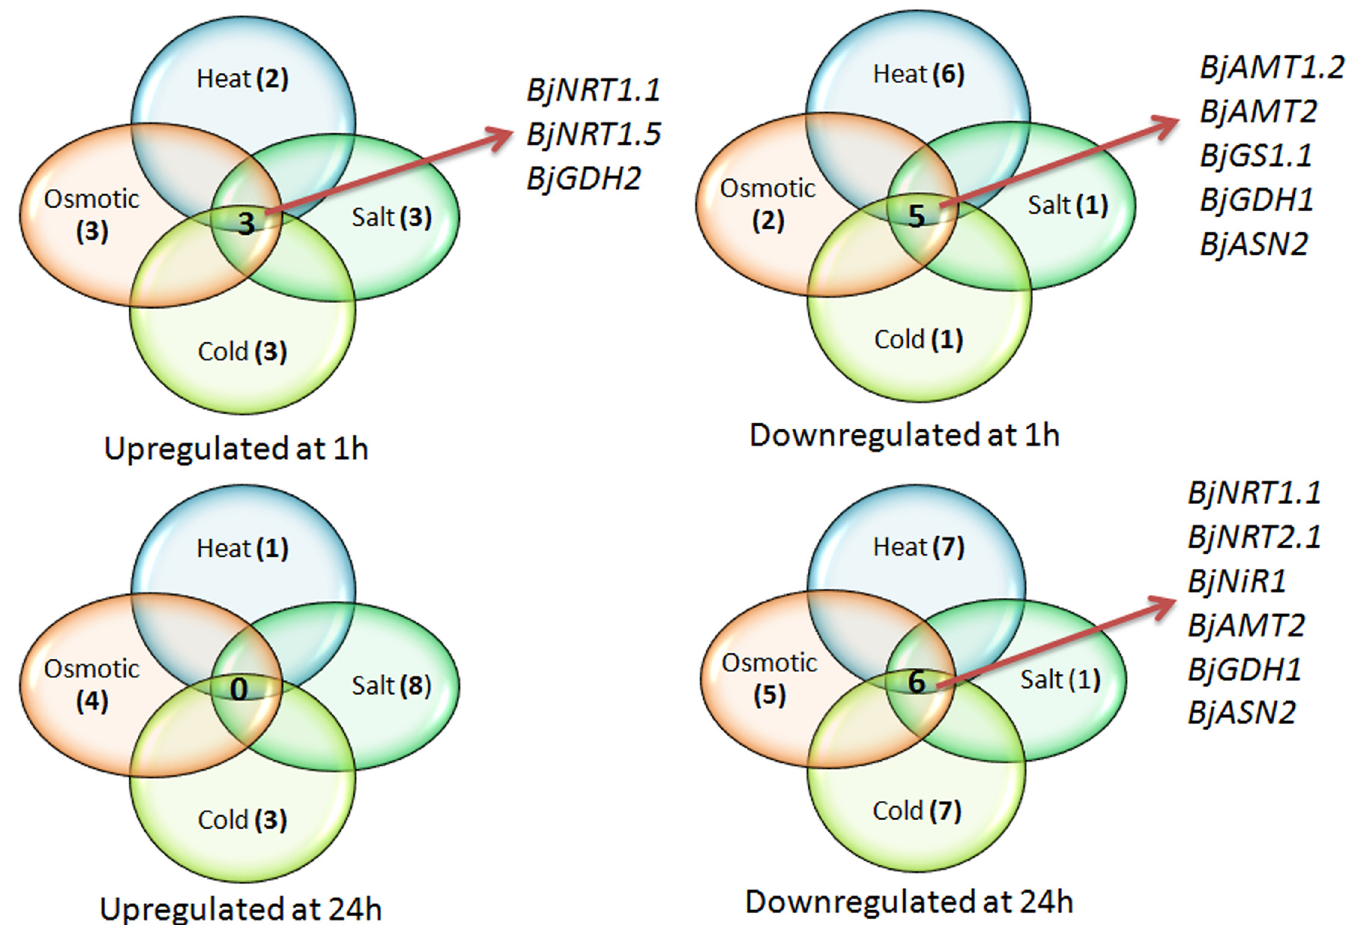
Fig 4. Venn diagram showing genes commonly upregulated and downregulated after 1h and 24h of stress